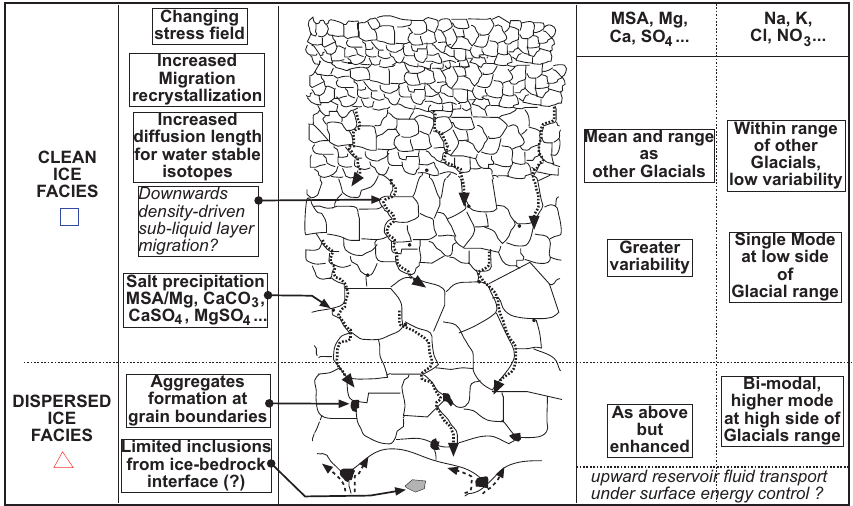
Figure 8. Sketch of potential chemical sorting effects during enhanced migration recrystallization processes under a changing stress field, close to the pressure melting point, in the clean and dispersed basal ice facies of EPICA Dome C. Processes in italic/dotted arrows are hypothetical (see text for